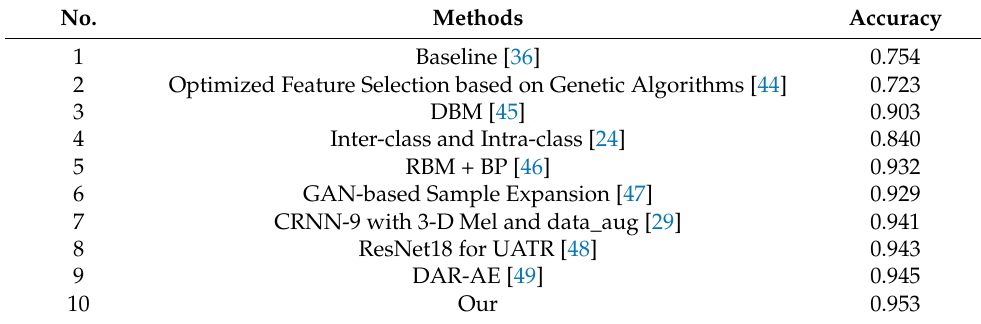
Table 8. Comparison between the proposed method and other methods used